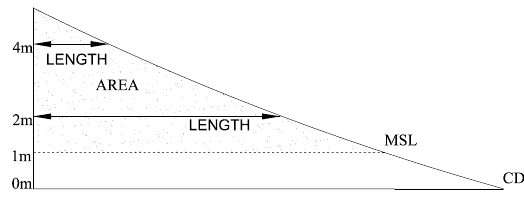
Fig. 2. Beach profile area (volume per meter) above 1 m chart datum (CD) (approximately mean sea level, MSL) and beach profile length at the 2 m and 4 m CD contour